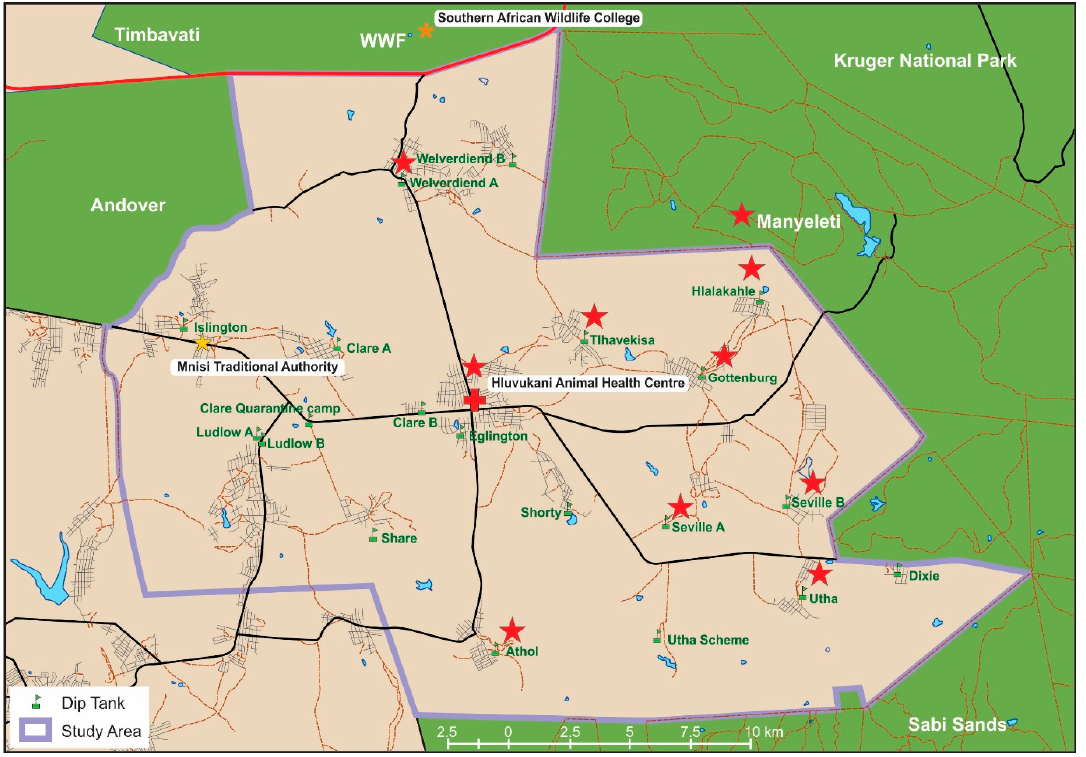
Figure 1. Map of the study area. The purple boundary shows the edge of the Mnisi community area. Red stars indicate locations of sample collections. Green indicates protected areas where wildlife roam freely.